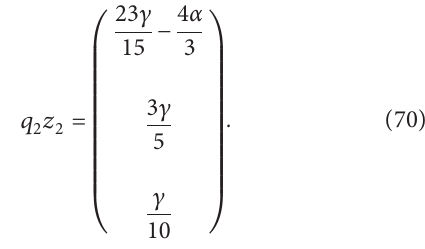
Figure 8: Regions R